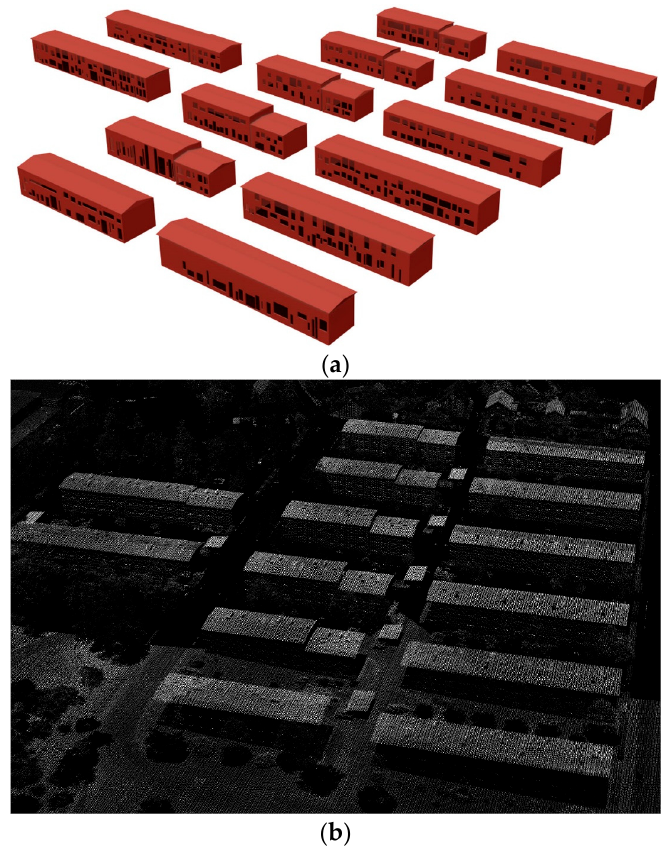
Figure 18. Reconstructed 3D building models: ( a ) 3D building models; and ( b ) point cloud with intensity.